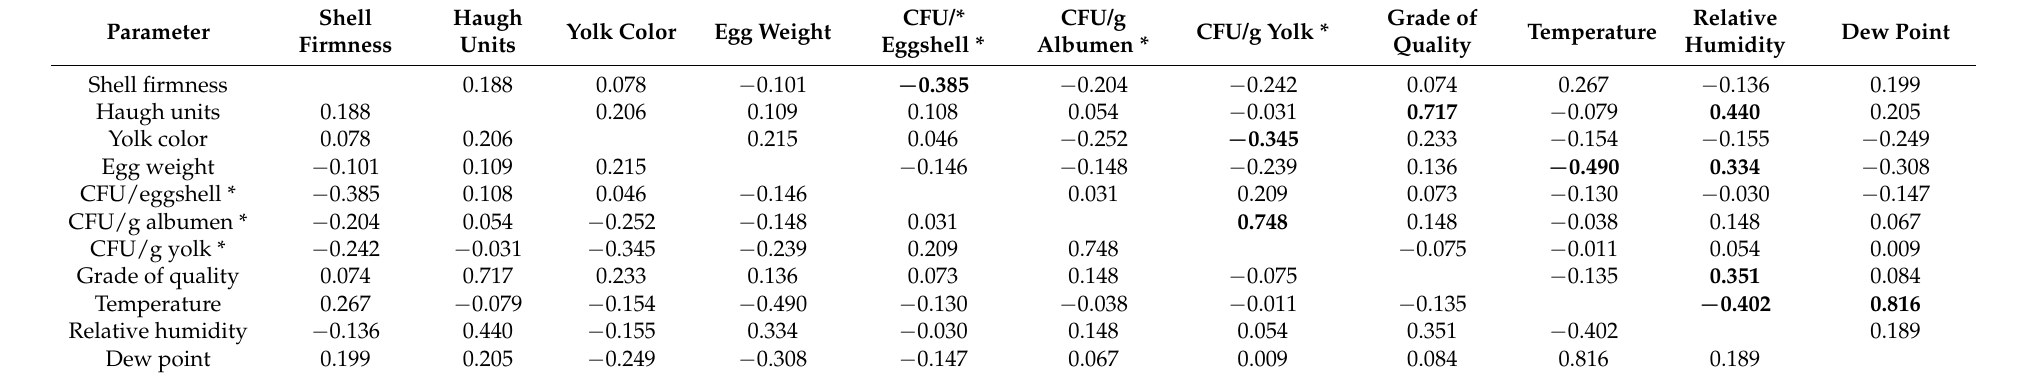
Table 6. Pearson’s correlation matrix for egg quality parameters (significant differences are highlighted in